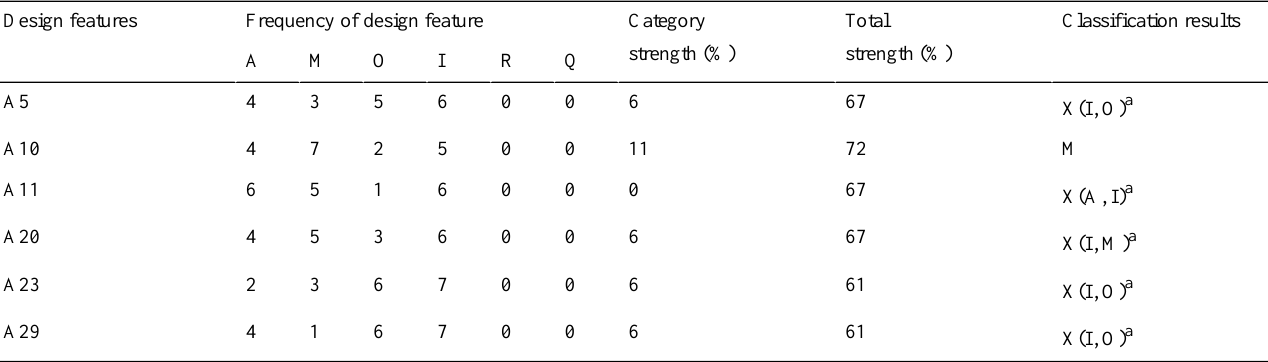
Table 6. Categorizing design features by medium physical activity participants